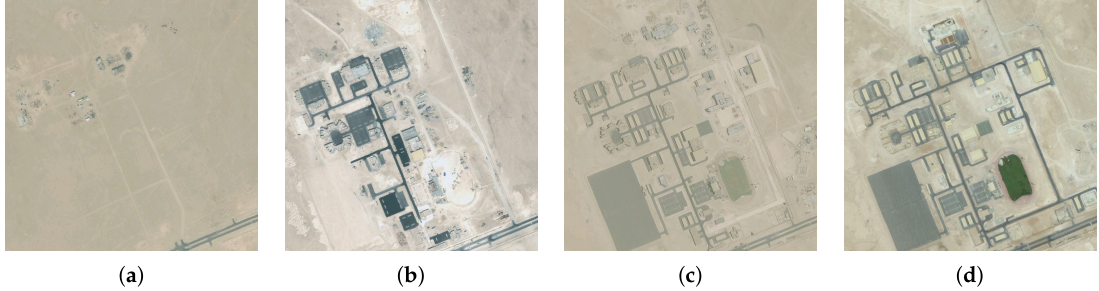
Figure 8. The time series images in the AUAB dataset. Remote sensing images taken in ( a ) 2002, ( b ) 2006, ( c ) 2009, and ( d ) 2011.